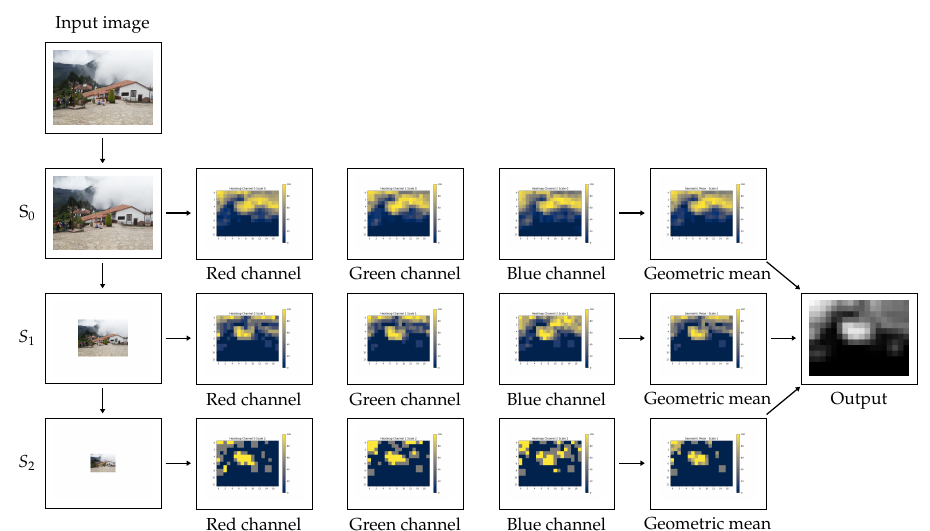
Figure 2. Complete pipeline of the method: successive scales are extracted from the input image. At each scale, one heatmap per color channel is computed and then combined according to their geometric mean. Finally, the obtained heatmaps at each scale are summed and normalized to produce the final output. Algorithm 1 Pseudo-code for the proposed